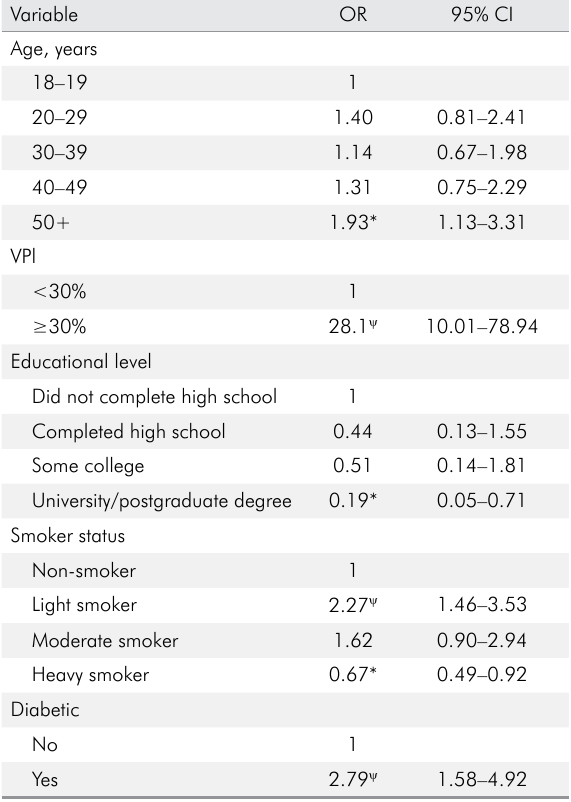
Table 3. Multivariate logistic regression model of risk indicators of severe gingival inflammation (GI > 2) in